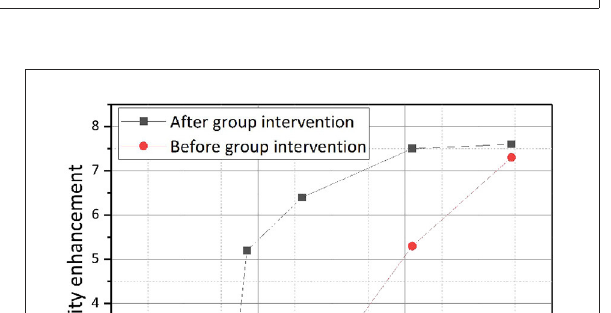
FIGURE6 Smartphone learning channels for older adults with no residence patterns.